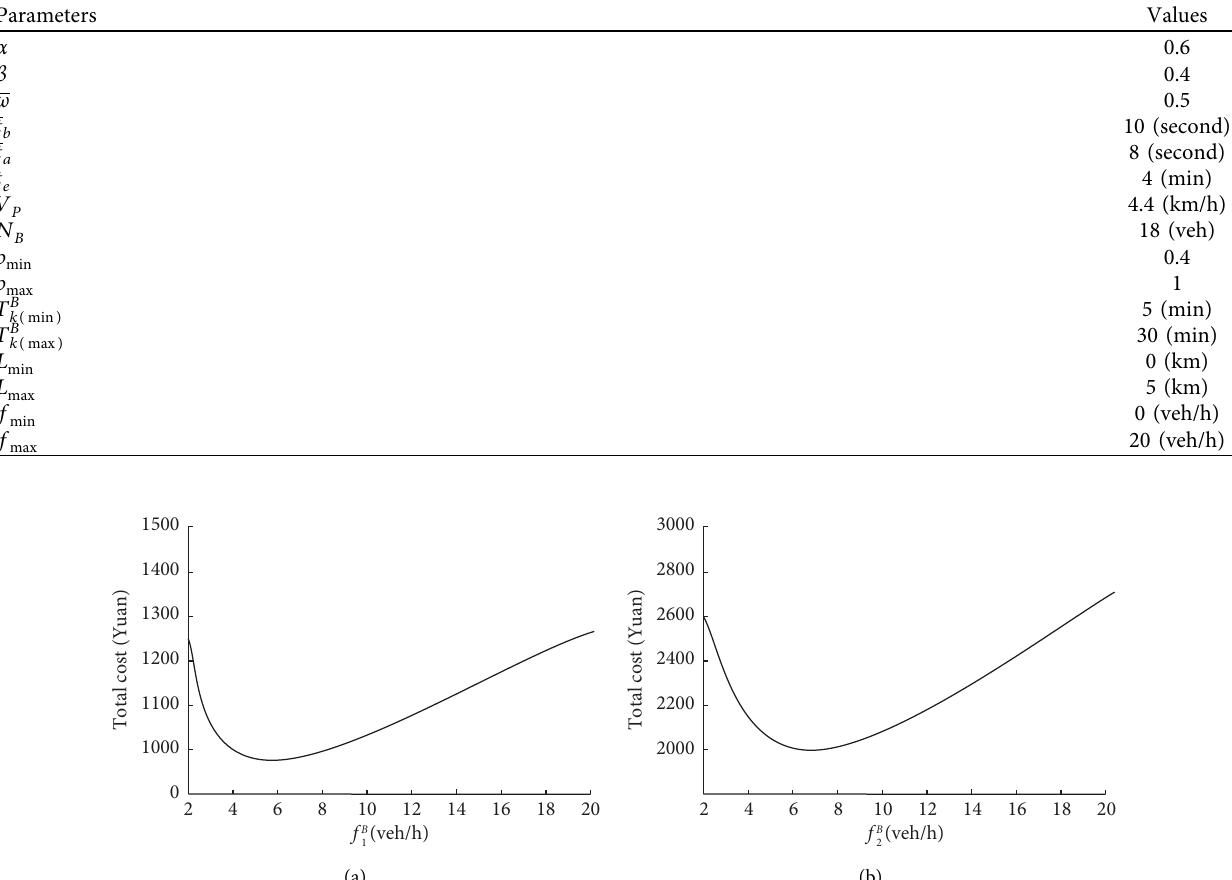
Table 5: Values of related parameters in the model.